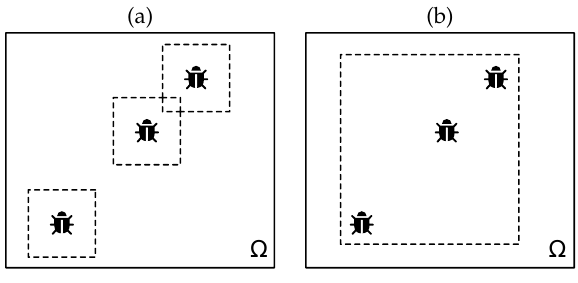
Figure 2. The original HSA defined a smaller search region around each recruiter. The proposed parallel version defines a unique region that contains the recruiters. ( a ) Original; ( b ) New proposal.